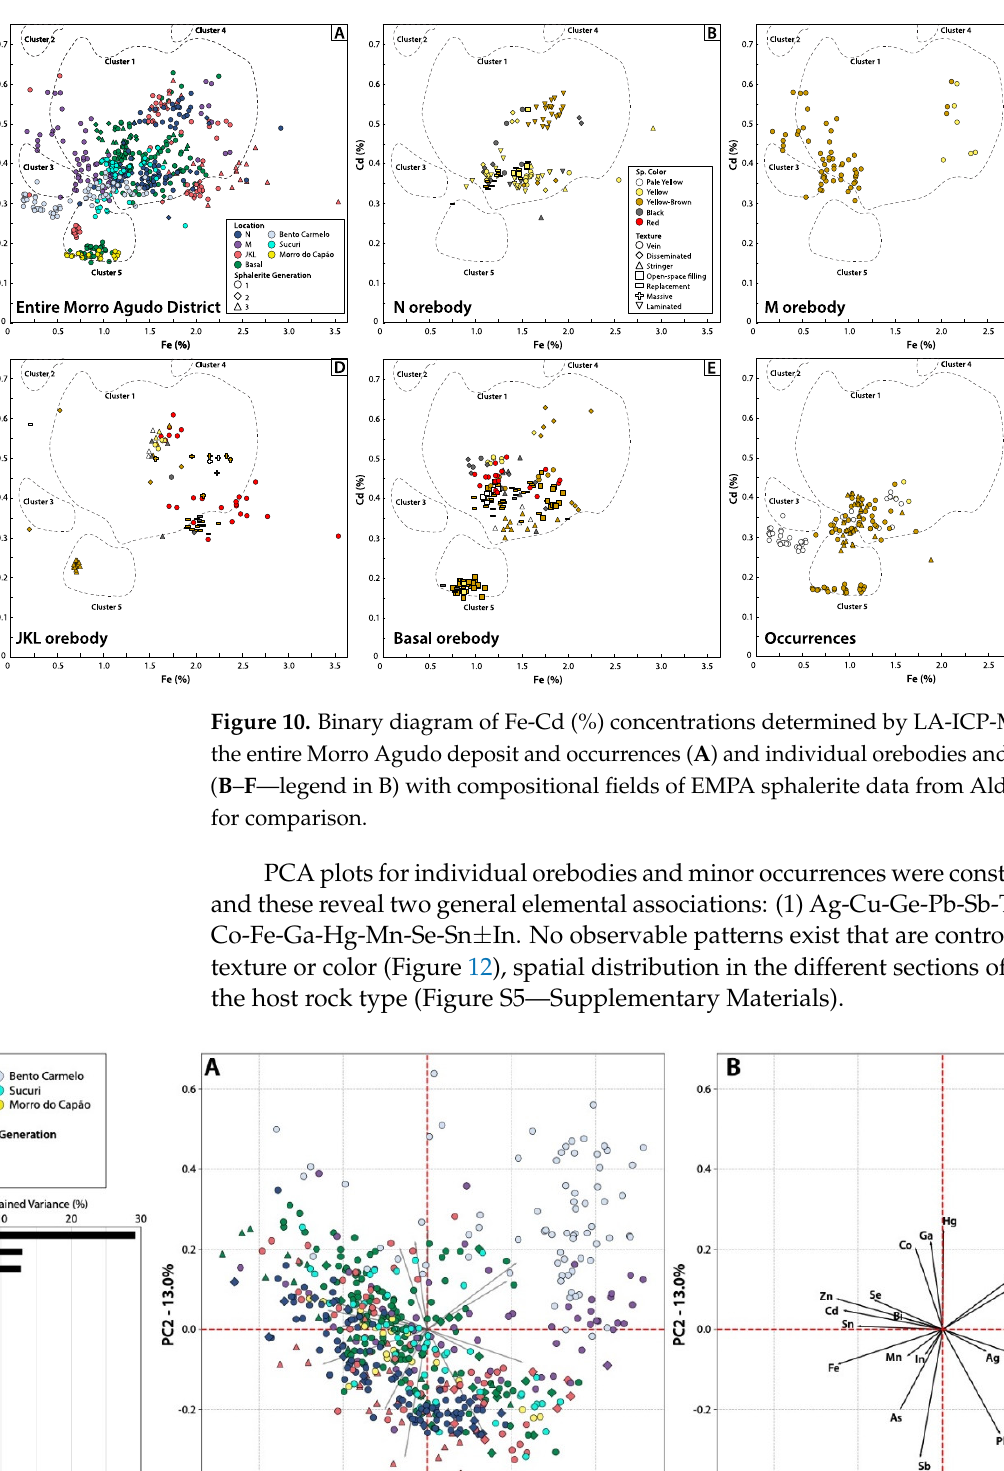
Figure 9. Box-and-whisker plots of trace elements ( A ) Ag, As, Bi, Cd, Co, Cu, Fe, Ga, Ge, ( B ) Hg, In, Mn, Pb, Sb, Se, Sn, and Tl in sphalerite distinguished by color. All units are in ppm except Cd and Fe (wt. %). Note the logarithmic scale and corresponding mean value.